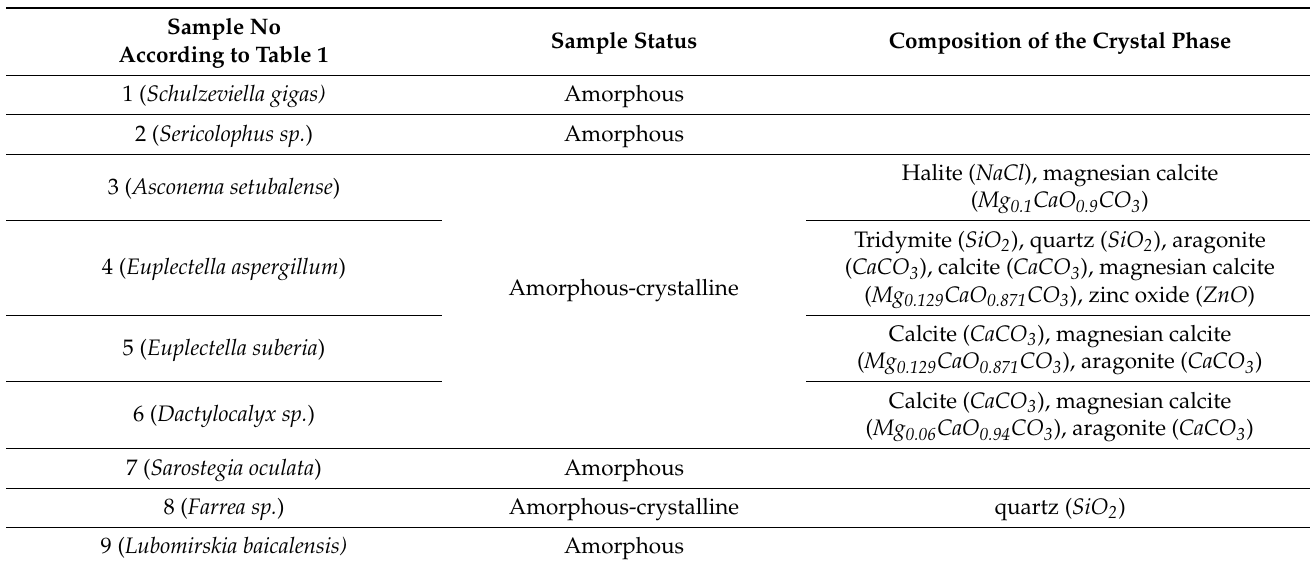
Table 3. Results of X-ray phase